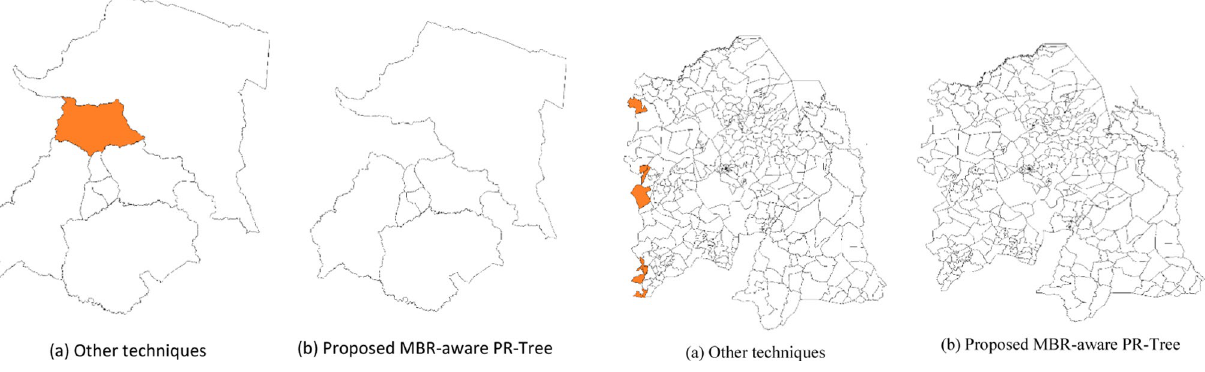
Fig. 13 Range query with a random query window area 0.001% of Cities